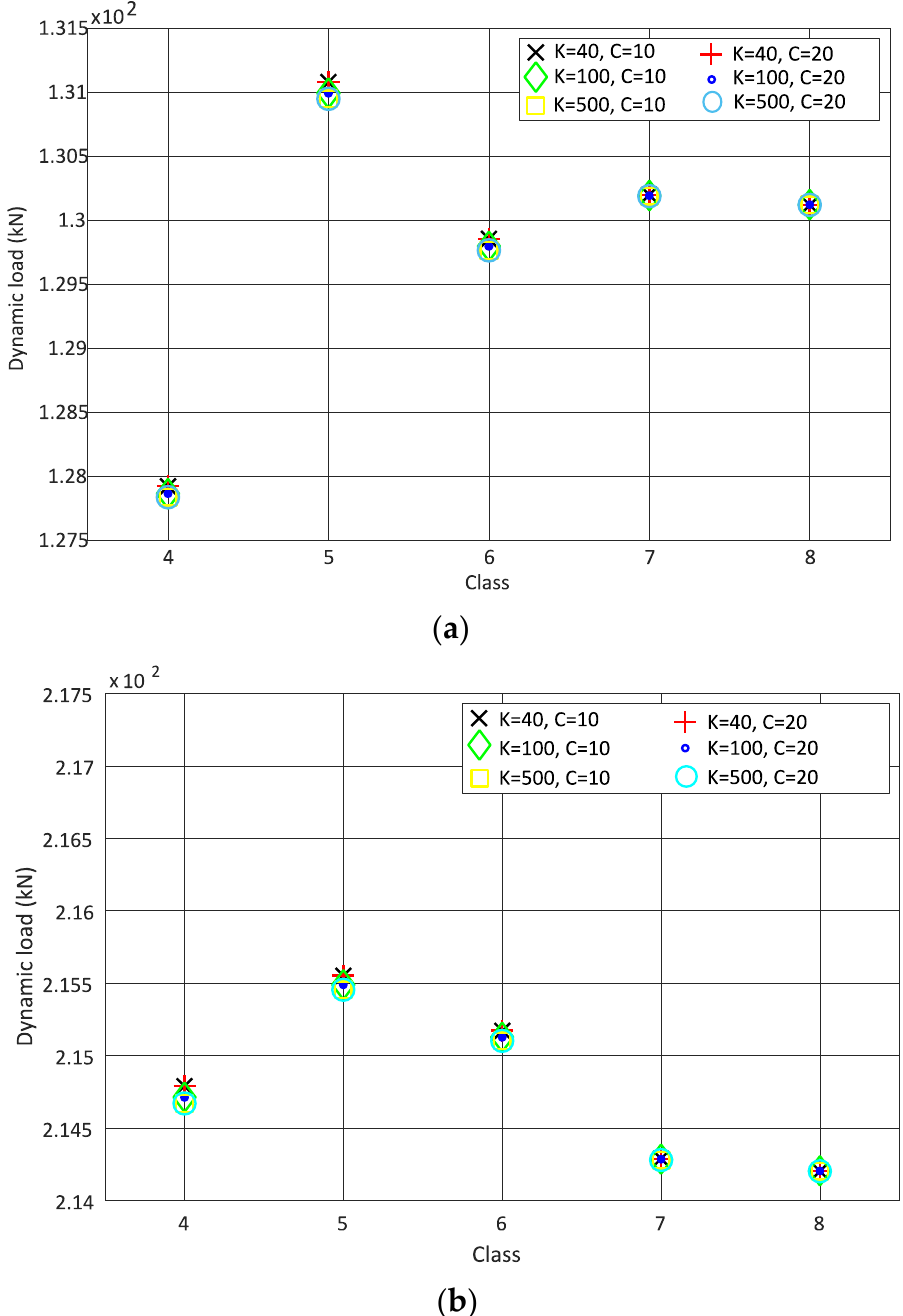
Figure 7. Influence of the rail pads stiffness and damping on dynamic load: ( a ) Alfa Pendular; ( b ) freight wagon.